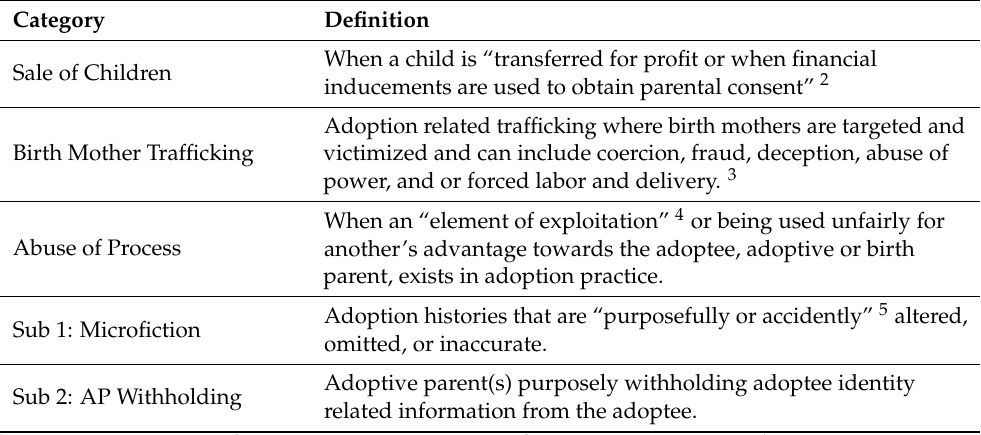
Table 2. Illicit Transnational Adoption Practice Definitions 1 .